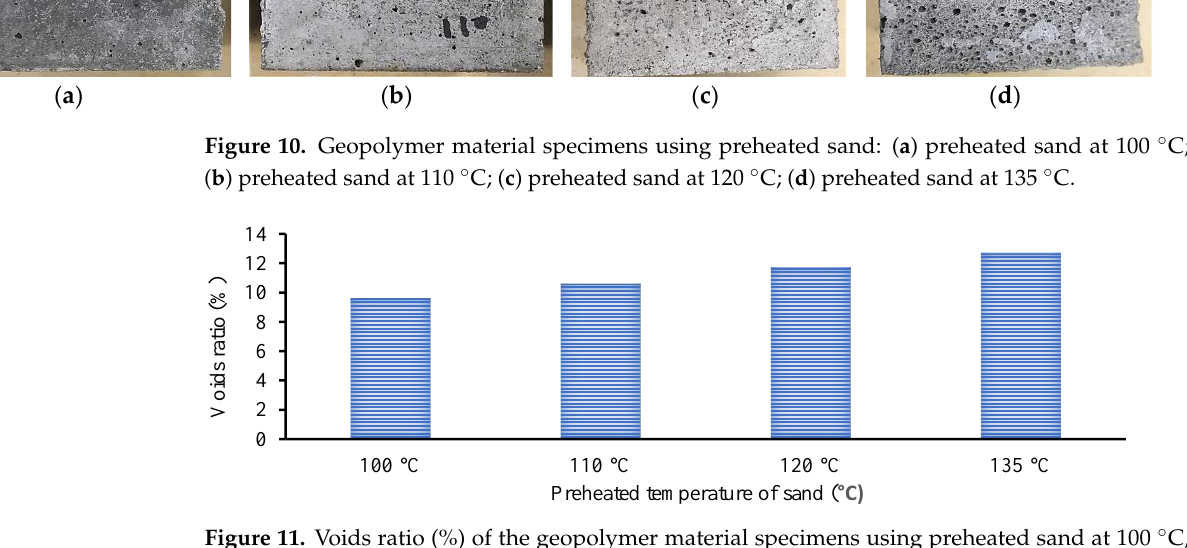
Figure 11. Voids ratio (%) of the geopolymer material specimens using preheated sand at 100 °C, 110 °C, 120 °C, and 135 °C.